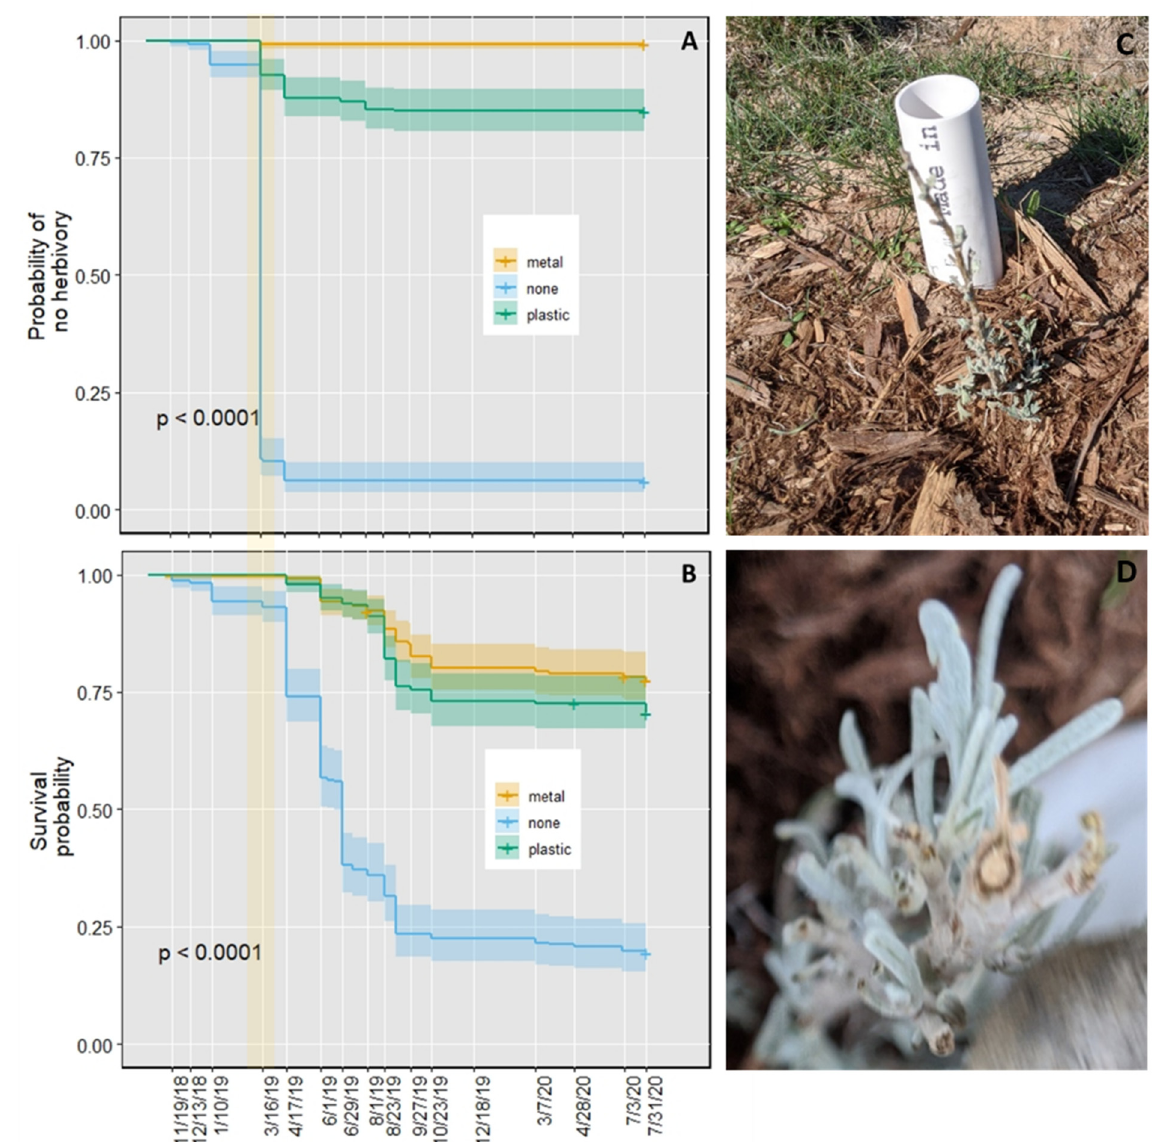
Figure 3. Herbivory damage and survival of Artemisia tridentata seedlings outplanted in October 2018. Probability of no herbivory damage ( A ) and survival ( B ) under the different tree protector treatments. Representative picture of herbivory damage in early spring 2019 in plants without protectors ( C ) and a close view of a cut stem ( D ). The shaded area in ( A , B ) indicates the period of major herbivory. Curves in ( A , B ) are medians and 95% confidence intervals.